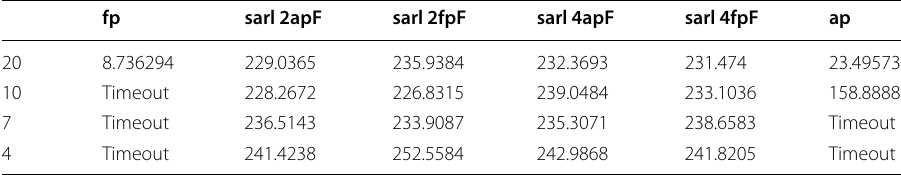
Table 17 Running times of different algorithms on the T40I10D100K dataset fp sarl